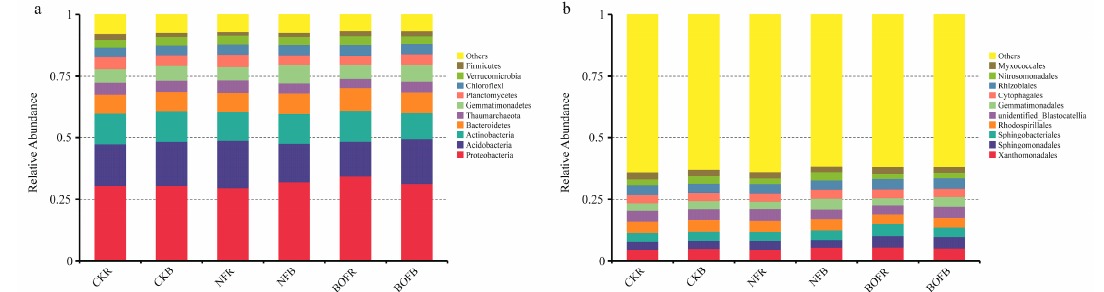
Figure 1. Bacterial community composition at the ( a ) phylum level and ( b ) order level in different fertilization treatments. CKR, rhizosphere of no fertilizer; CKB, bulk of no fertilizer; NFR, rhizosphere of nitrogen fertilizer; NFB, bulk of nitrogen fertilizer; BOFR, rhizosphere of bioorganic fertilizer; BOFB, bulk of bioorganic fertilizer.